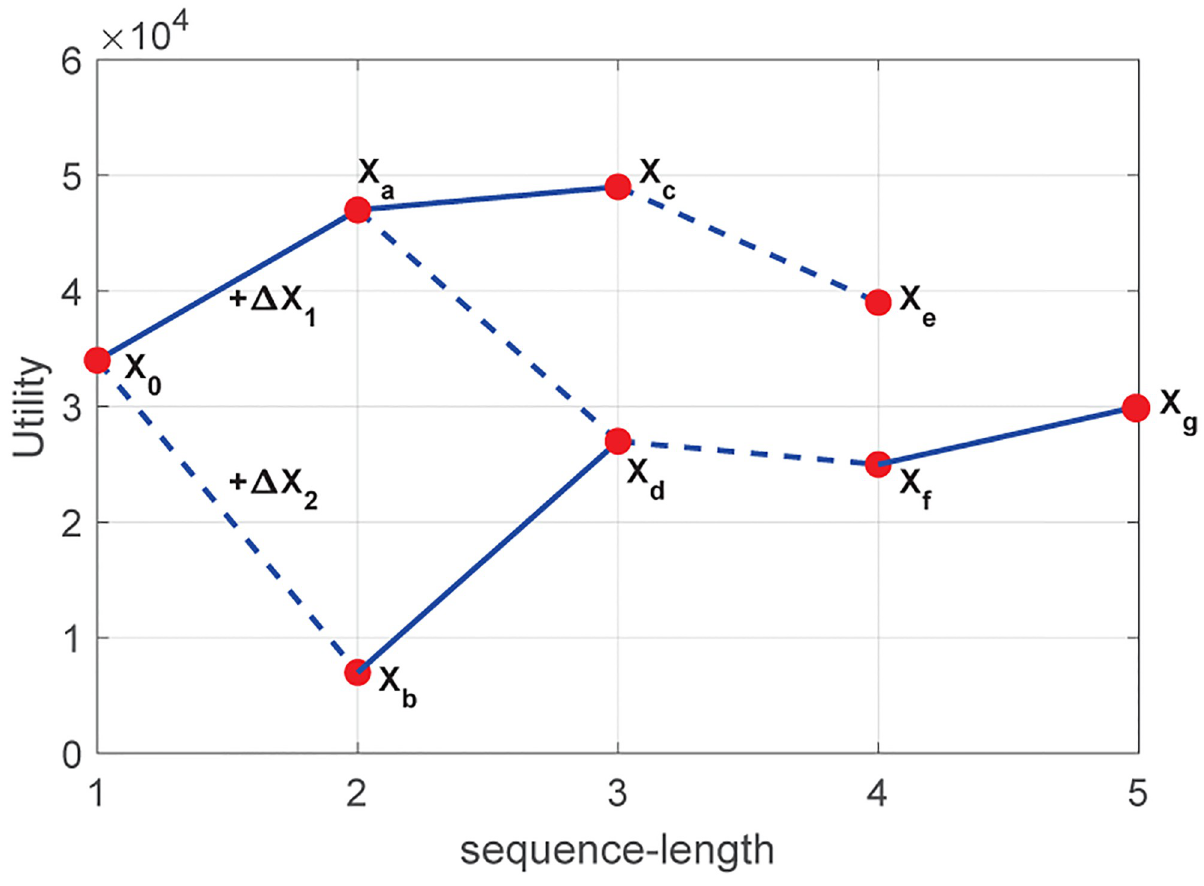
Fig 2. Incremental sequences with utility